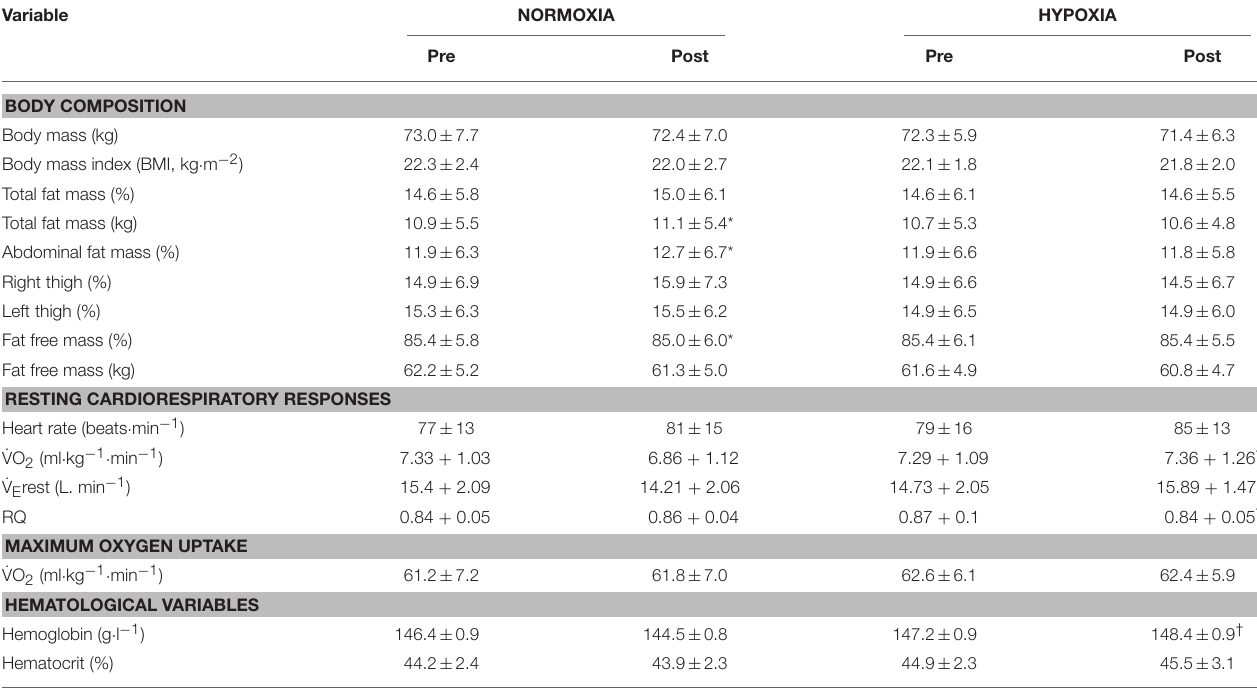
TABLE 1 | Body composition, cardiorespiratory and hematological responses before (PRE) and after (POST) the 10-day NORMOXIA and HYPOXIA confinements.